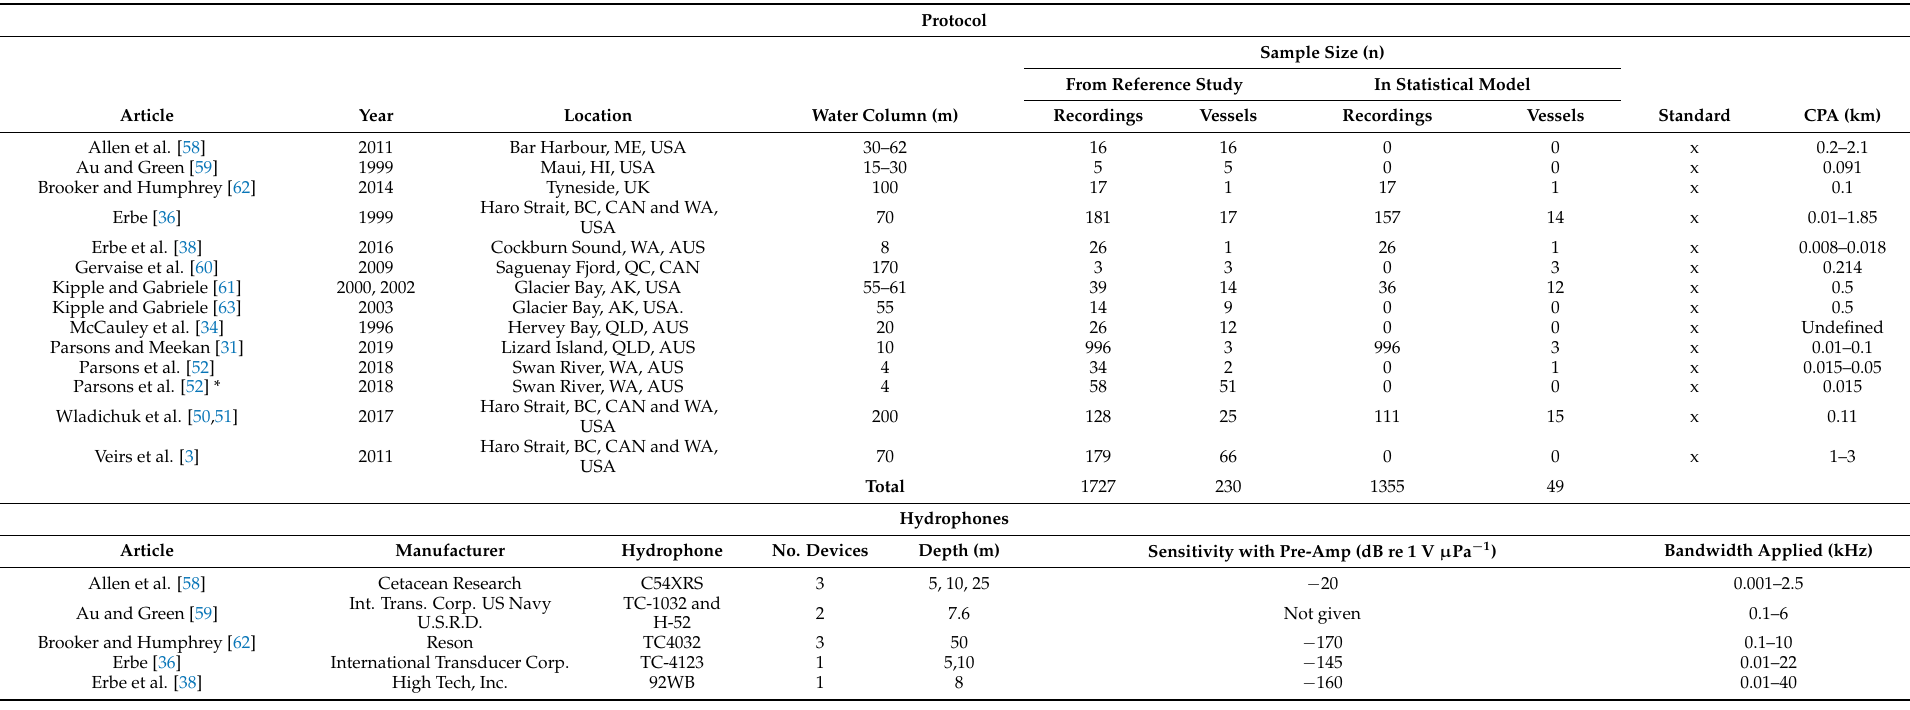
Table 4. Details of the experimental designs and data processing of examined